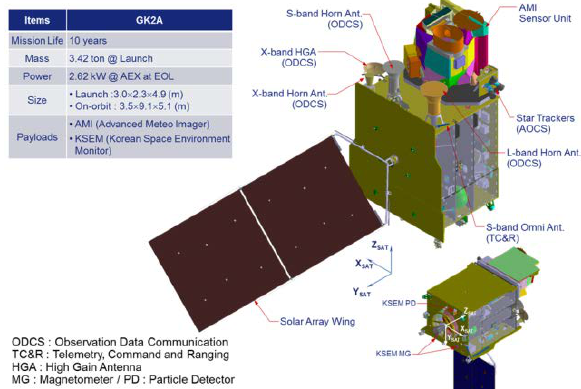
Figure 1. Description of GK-2A mission. It is equipped with Advandced Meteorological Imager (AMI) and Korean Space Environment Monitor (KSEM) payloads (image available from the Korea Aerospace Research Institute